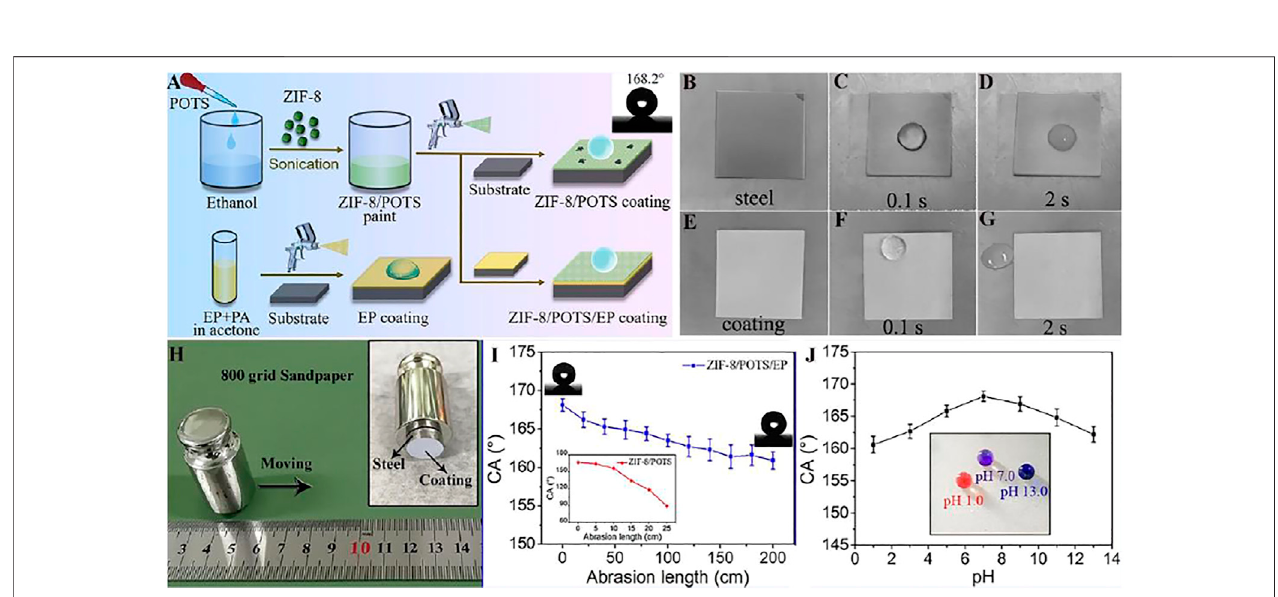
FIGURE11|(A) ThemanufacturingprocessofEPcoating, superhydrophobicZIF-8/POTScoating andZIF-8/POTS/EPcoating. Thepicturesof (B – D) Q235steel sheetand (E – G) ZIF-8/POTS/EPcoating after (B , D) 2 hin − 20 ° Crefrigerator,andafter (C , F) 0.1sand (D , G) 2 sofdripping 0 ° Cwaterdropletsontheirsurfaces. (H) The schematic of sandpaper abrasion test, and (I) the change of abrasion length on the CA. (J) The change of pH values of water droplet on the CA of ZIF-8/POTS/EP coating, inset picture is the photograph of litmus colored water droplets with different pH value on ZIF-8/POTS/EP coating (Chen et al., 2021).